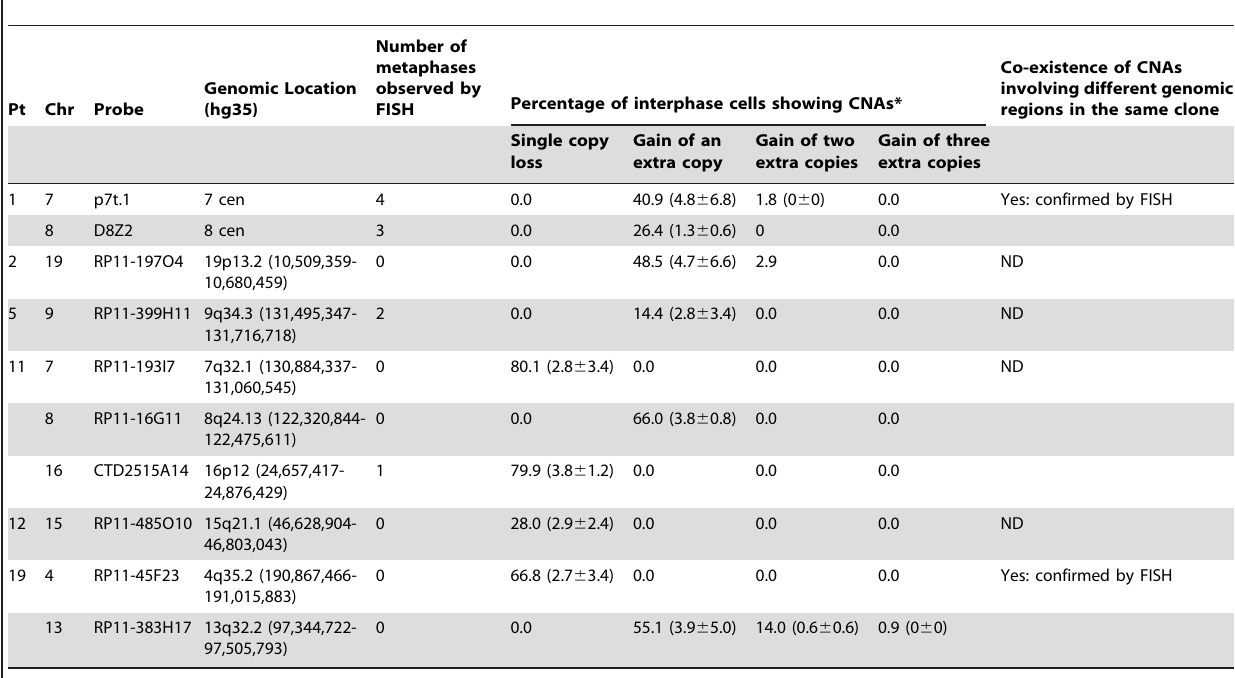
Table 2. Summary of FISH results for all AML paediatric patients reported in this study.